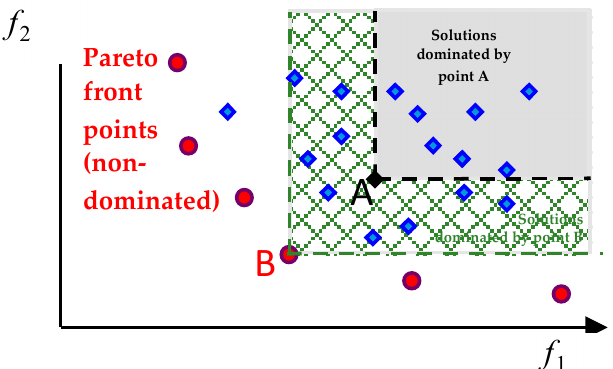
Figure 6. Concept of Pareto dominance. The functions f 1 and f 2 are minimized.